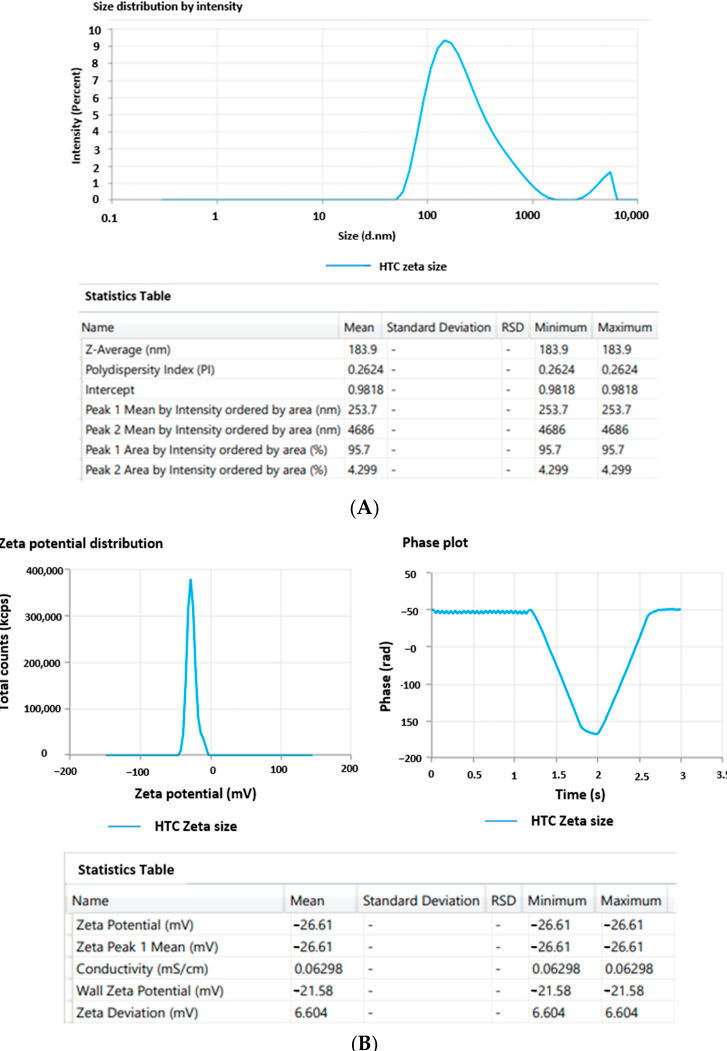
Figure 2. ( A ) Average particle size distribution; ( B ) average zeta